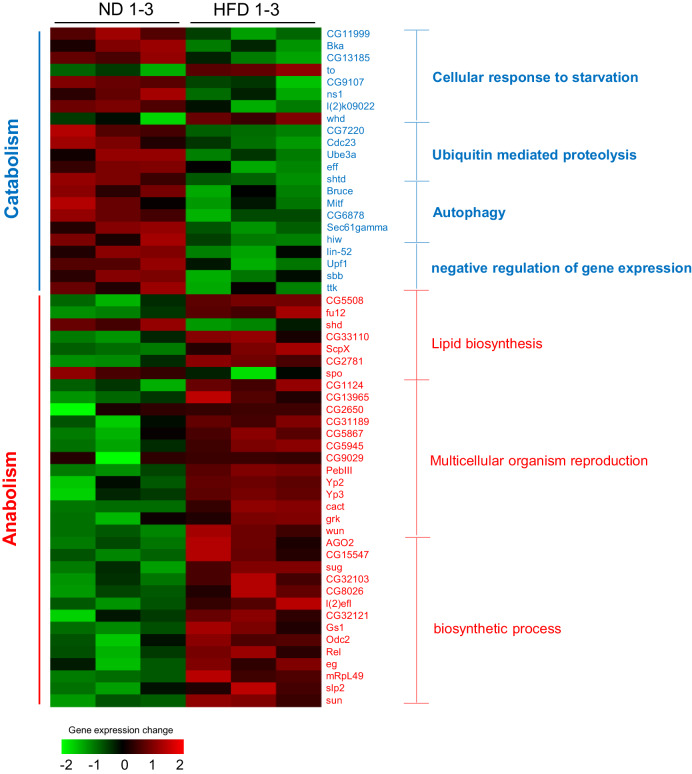
TOR downstream genes are modulated by HFD feeding.Heat map of differentially expressed genes enriched in TOR signaling pathways. Wild-type virgin female flies were fed with ND or HFD for 5 d before their head tissues harvested and subjected to RNAseq. Green and red blocks represent down-regulated genes and up-regulated genes upon HFD feeding, respectively. Red and blue font colors indicate anabolism and catabolism genes, respectively. Note that most anabolism related genes were up-regulated while most catabolism related genes were down-regulated by HFD.